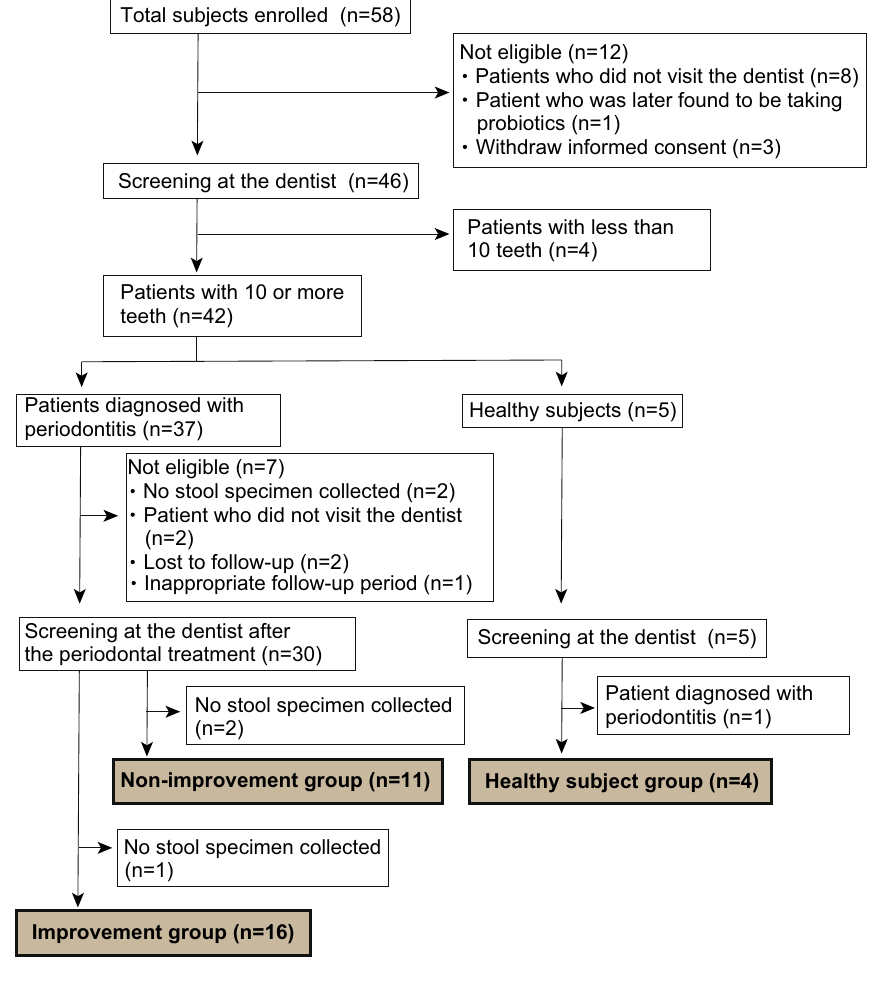
Figure 1. Flow diagram of the